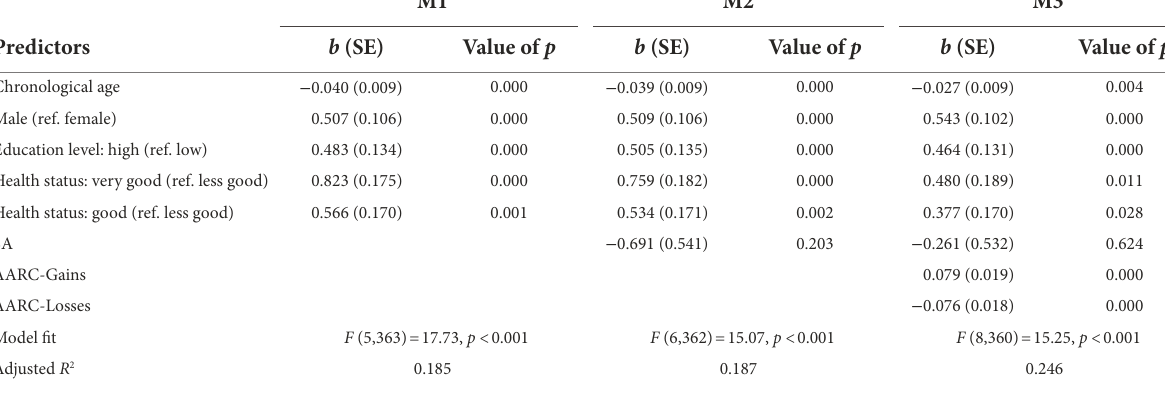
TABLE 2 Stepwise linear regression analyses to predict technology skills.